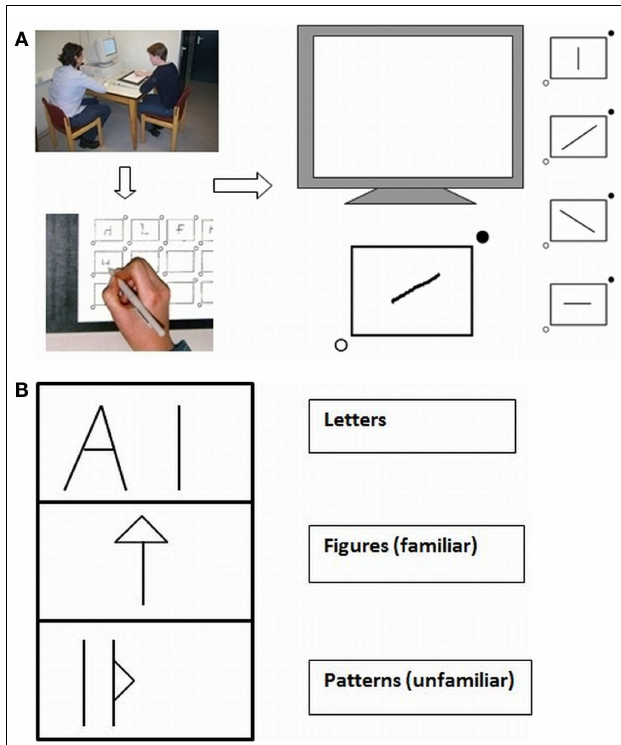
FIGURE 1 | (A,B) Set up (A) of the line and complex figure copying task (B) with pressure-sensitive